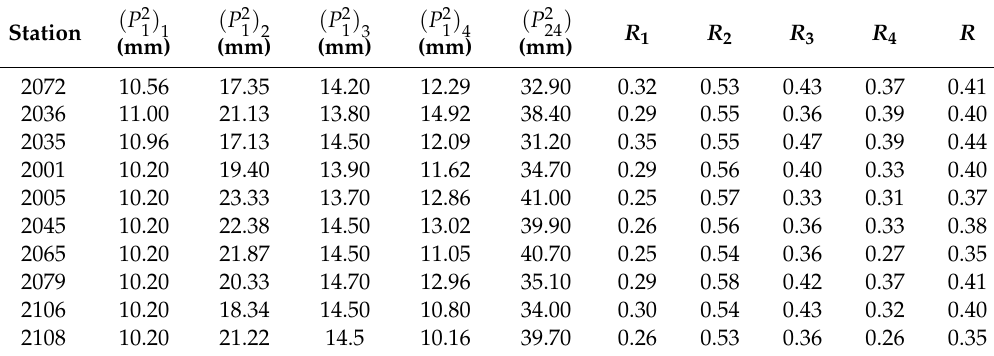
Table 5. Depth-duration ratio ( R ) estimated through the average ratios R 1 ... 4 estimated from ( P 2 ) and ( P 2 ) . Where ( P 2 ) was averaged of pluviograph and daily records applying Gumbel, 1 24 1 1 ( P 2 ) calculated by Hershfield [26] and Bell [28], ( P 2 1 2 by the adjusting and modification of Bell [28] (Equation